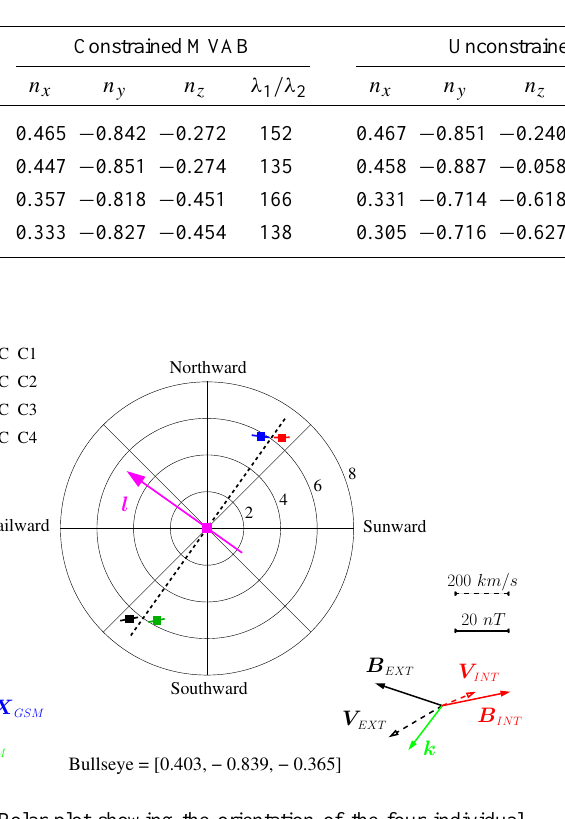
Table 1. Results from the constrained (to h B n i= 0) and unconstrained MVAB averaged over the eleven nested intervals, as well as from the constrained (to h B n i = 0) MFR technique. For each satellite, ordered here by the time of MP encounter, the GSE components of the normal vector, together with the corresponding eigenvalues ratio are presented. In case of the unconstrained MVAB, the resulting average normal magnetic field component is provided as well. The last column shows the angle between the MFR normals and the plane of the normals . More details are provided in the text.